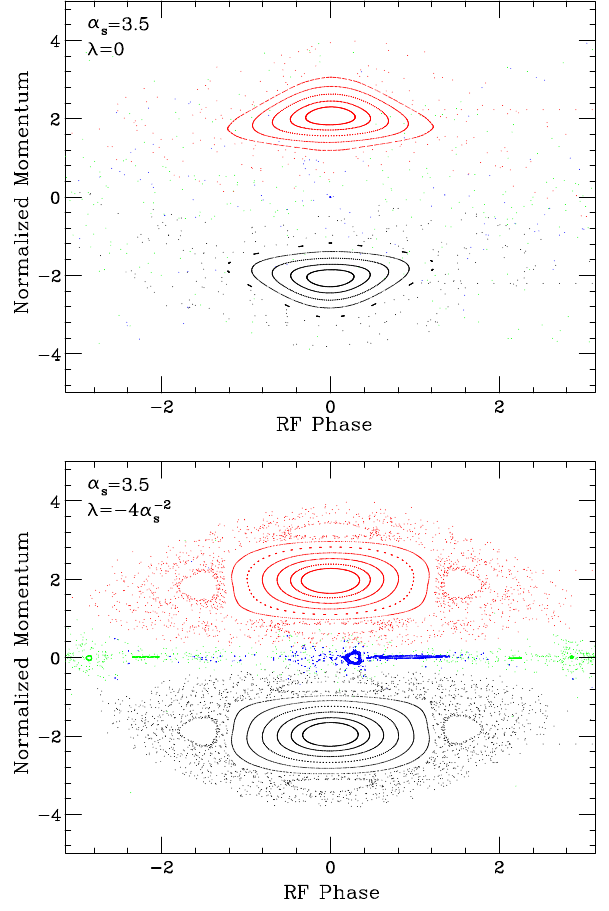
FIG. 5. Phase-space structure with slip-stacking parameter α ¼ 3 . 5 is shown in the top plot with no second-harmonic rf s compensation or λ ¼ 0 , and in the lower plot with second- harmonic rf compensation or λ ¼ − 4 = α 2 s ¼ − 0 . 327 . The com- pensation restores some of the structure resonances, but they are still embedded in the chaotic sea. The compensation does not cancel resonances associated with each slip-stacking